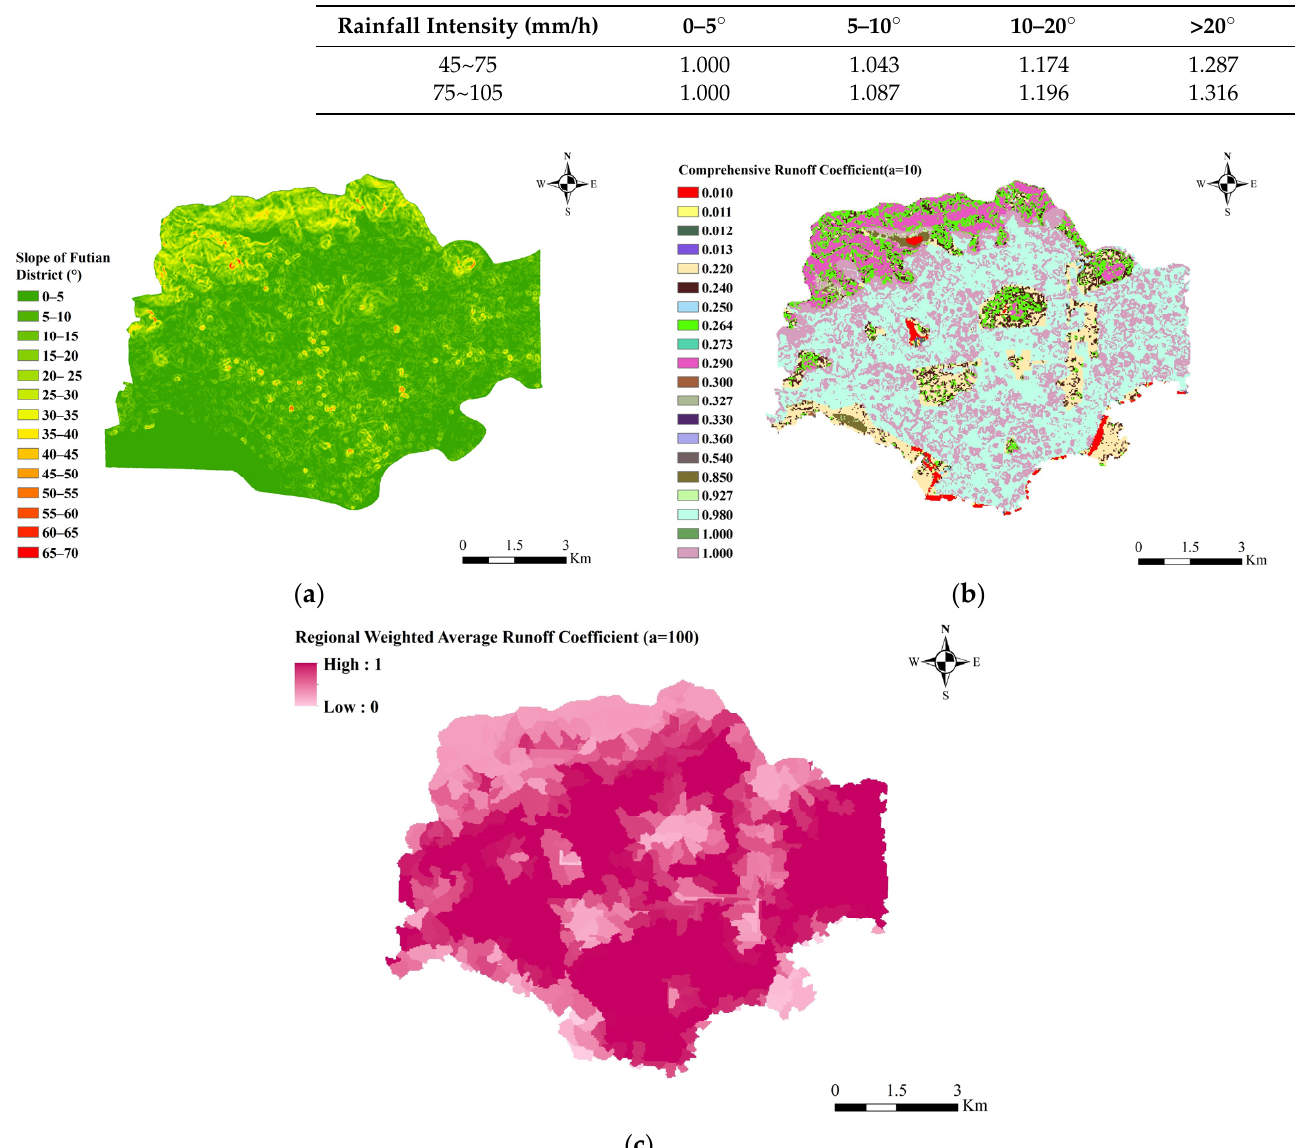
Figure 7. Slope distribution in Futian District ( a ), integrated runoff coefficient of each grid ( b ), weighted average runoff coefficients for each sub-catchment in Futian District ( c ). Table 5. Effect of slope and rainfall intensity on runoff coefficient.